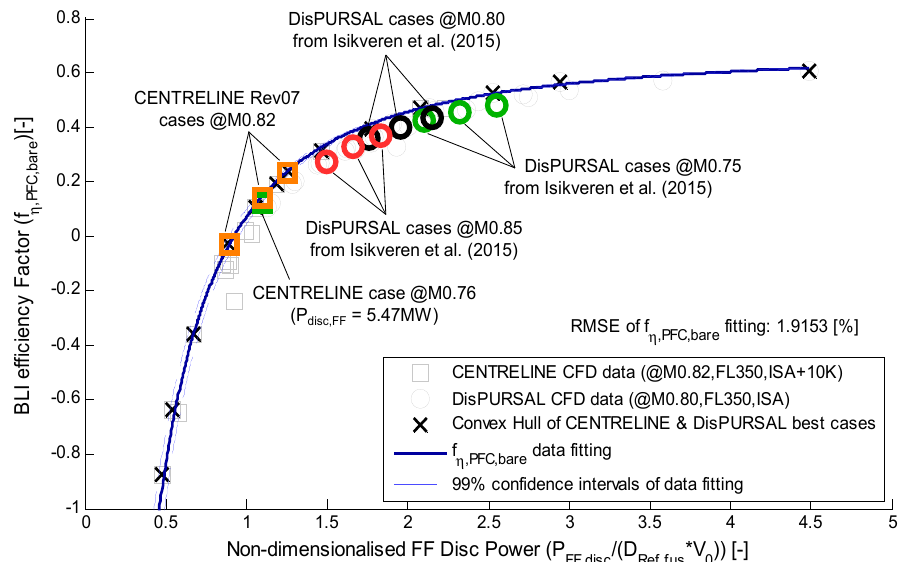
Figure 31. Non-dimensional analysis of BLI efficiency factor for CENTRELINE and DisPURSAL aero-shapings (adapted from [50]).